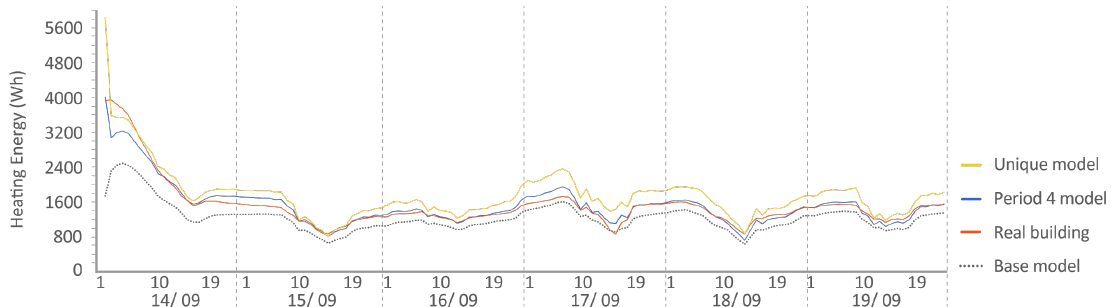
Figure 20. Energy consumed by house O5, Period 4 (set point at 25 ◦ C). Period 4 model: CV(RMSE): 9.30%, NMBE: − 0.01%, and R 2 : 94.36%. Base model: CV(RMSE): 25.78%, NMBE: − 0.09%, and R 2 : 86.36%. Unique model: CV(RMSE): 21.12%, NMBE: − 0.13%, and R 2 : 87.70%. It is remarkable the good performance of the base model in this case with a CV(RMSE) within ASHRAE standard. On some days, it improves the unique